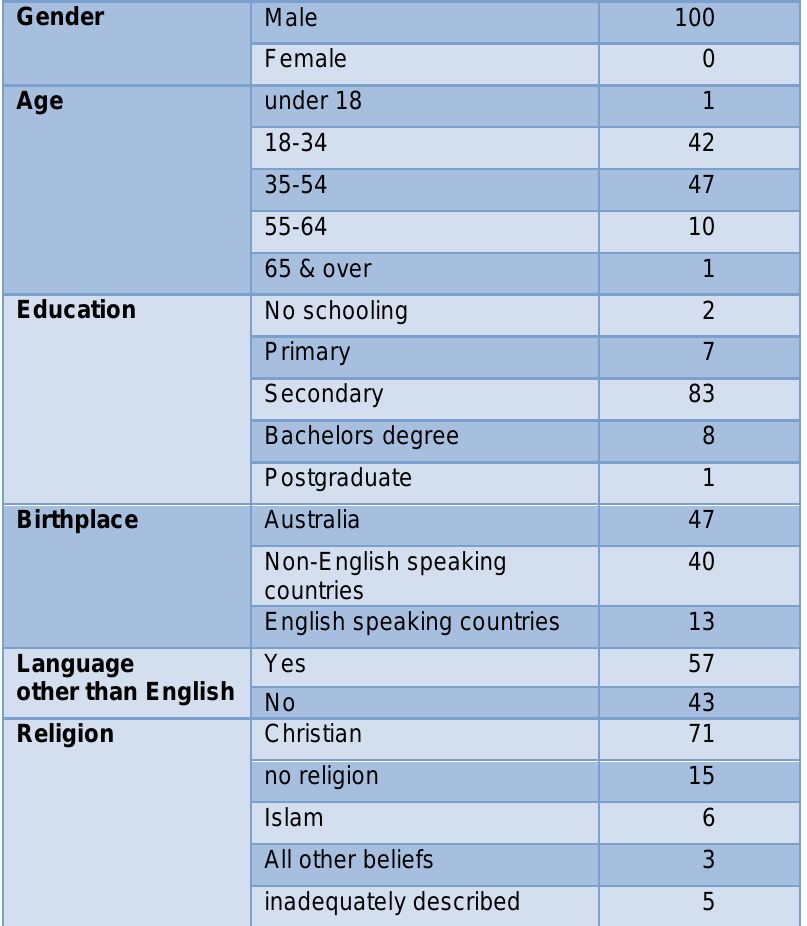
Table 1 Respondent demographics, Operatives’ survey, Sydney construction sites,